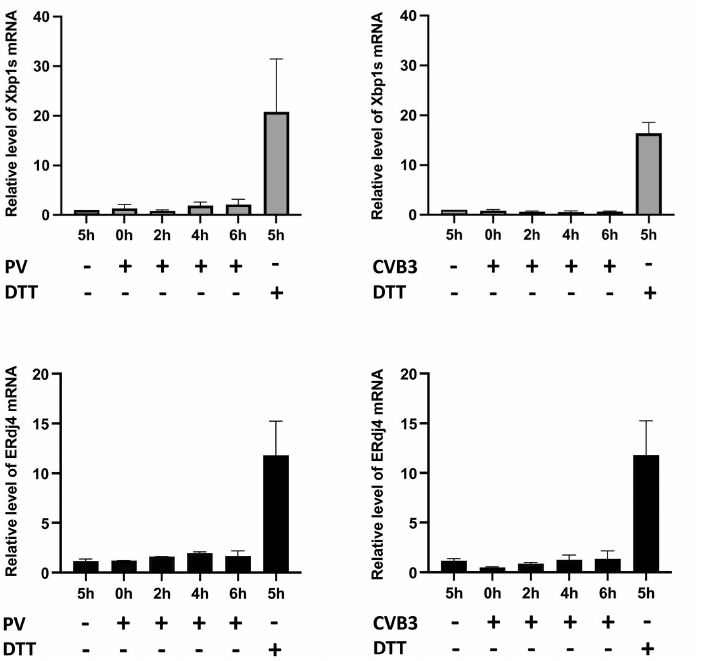
Figure 4. Enterovirus infection does not induce Xbp1 mRNA splicing and activation of the Xbp1 downstream target ERdj4. ( A ) Total RNA from HeLa cells infected with PV, mock-infected, or treated with 10 mM DTT was isolated at the indicated time points. The relative level of the spliced Xbp1 mRNA was measured by RT-qPCR with primers specific to Xbp1s mRNA isoform and to RPL19 mRNA as a reference. ( B ) The same experiment with CVB3. Each experiment was performed in duplicate and repeated at least three times. ( C ) Total RNA from HeLa cells infected with PV, mock- infected, or treated with 10 mM DTT was isolated at the indicated time points. The relative level of ERdj4 mRNA was measured by RT-qPCR with primers specific to the ERdj4 mRNA and RPL19 mRNA as a reference. ( D ) The same experiment with